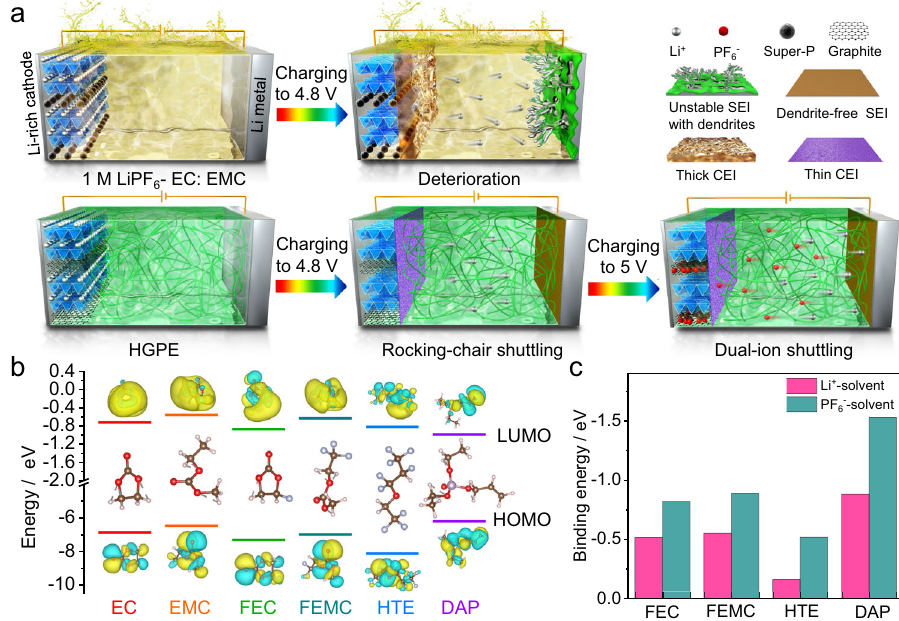
Fig. 1 The design of HGPE. a Schematic illustration of the mechanisms of a Li|1 M LiPF 6 -EC: EMC | LRO “ rocking-chair ” battery (upper panels) and a “ shuttle-relay ” battery with a hybrid LRO cathode using graphite as a conductive agent, a Li metal anode, and an HGPE (lower panels). b The LUMO and HOMO energy values of the solvent molecules. The molecular structures and corresponding visual LUMO and HOMO geometry structures are shown as insets. Brown, white, red, purple, and blue balls represent carbon, hydrogen, oxygen, phosphorus, and fl uorine atoms, respectively. c Binding energies of FEC, FEMC, HTE, and DAP for a Li + cation and a PF 6 −